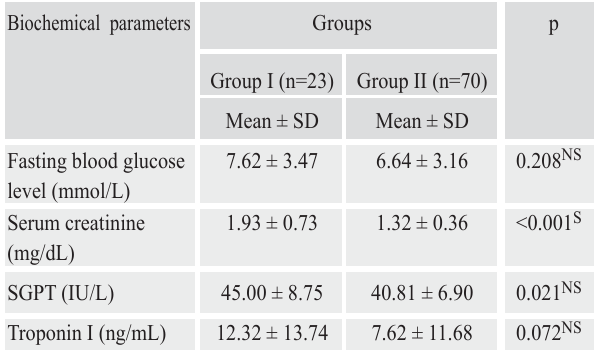
Table III: Comparison of biochemical parameters between two groups (N=93)